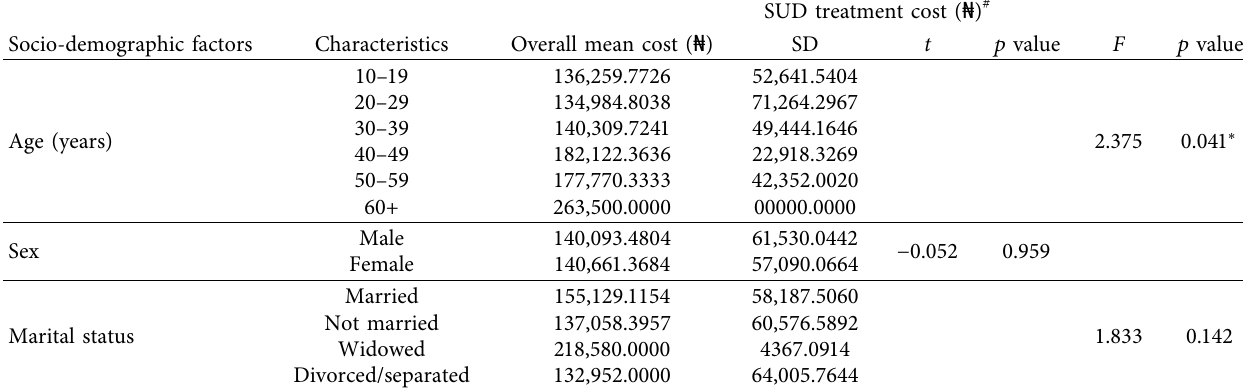
SUD treatment cost ( ₦ ) #